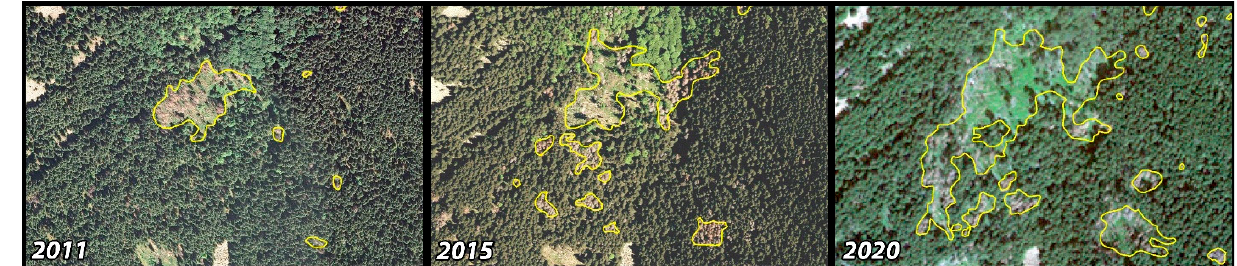
Figure 3. GIS application for the determination of the boundaries and areas of spruce stands attacked by Ips typographus on aerial (2011, 2015) and satellite (2020) RGB images.